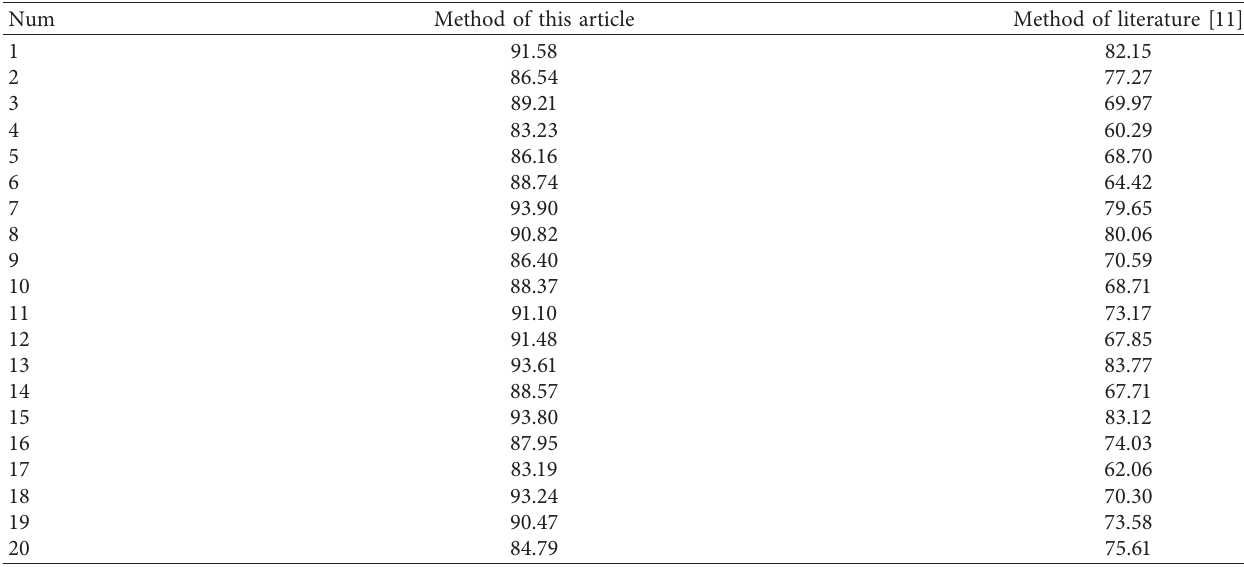
Table 1: Music frame feature recognition effect